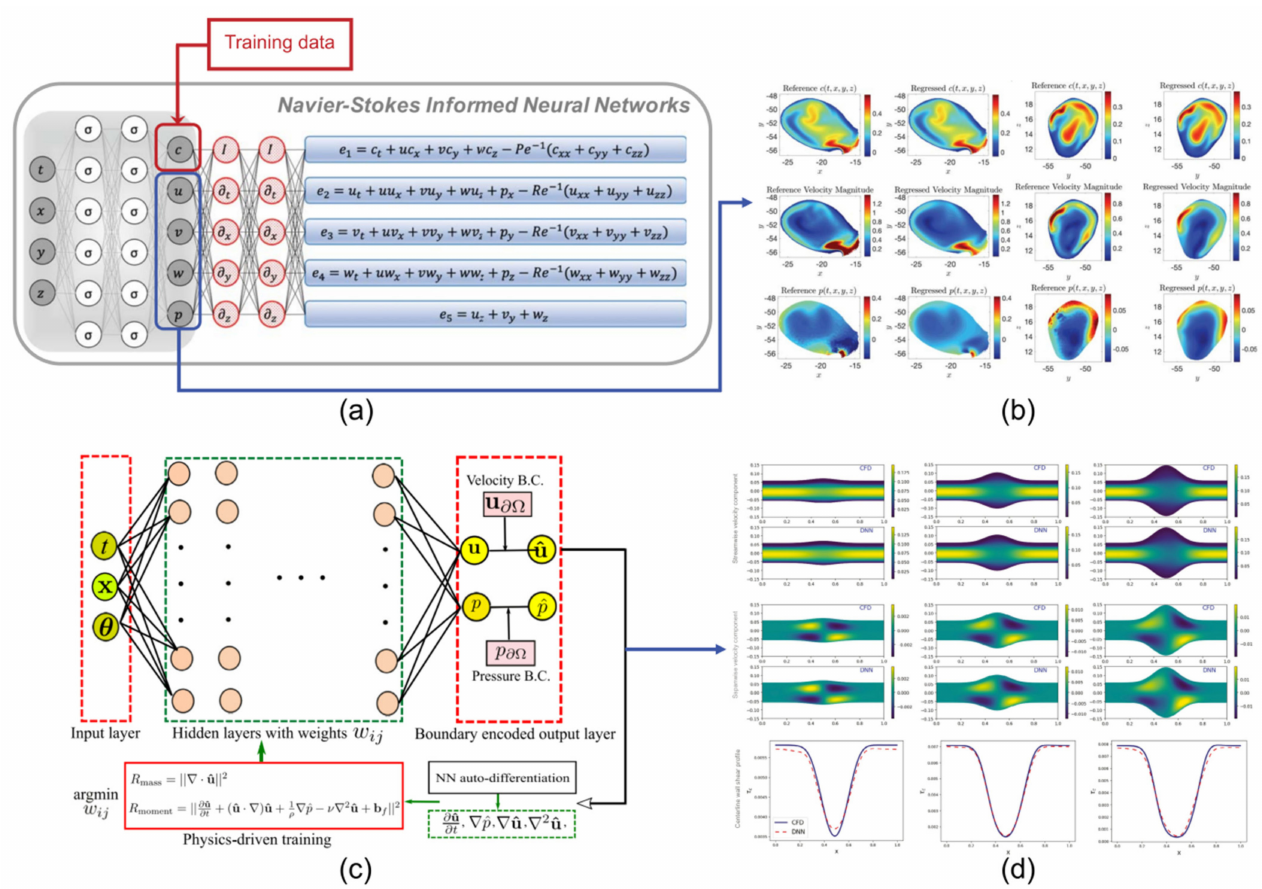
Figure 6. Case study for the physics − constrained, data − driven framework and data − free frame- work for surrogate modeling of fluid flows in aneurysms. ( a ) The data − driven structure of the Navier − Stokes − informed neural networks. The input data c is generated by using a direct numerical simulation, and the output is the quantitative hemodynamic parameters. ( b ) Contours of reference and regressed concentration, velocity, and pressure fields within the 3D intracranial aneurysm sac. ( c ) The data − free neural network is developed by coding boundary conditions with construction and trained by minimizing the loss function based on equations instead of CFD simulation data. ( d ) Contours of physics − constrained deep neural network predictions and CFD solutions of three different aneurysm geometries. Panel ( a , b ) are adapted with permission from Reference [126]. Science. Panel ( c , d ) are adapted with permission from Reference [86].